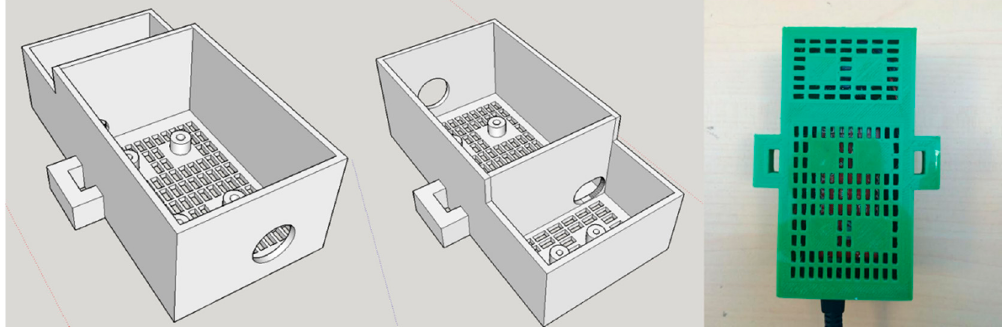
Figure 2. iAir prototype.